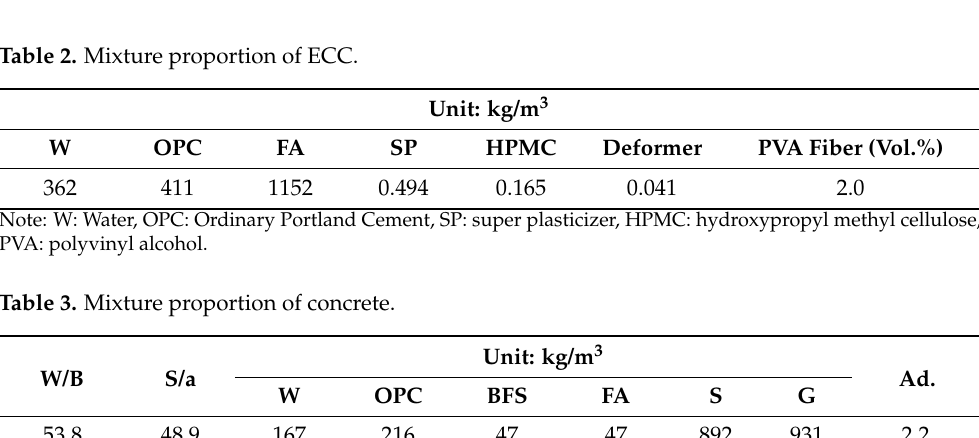
Table 3. Mixture proportion of concrete.